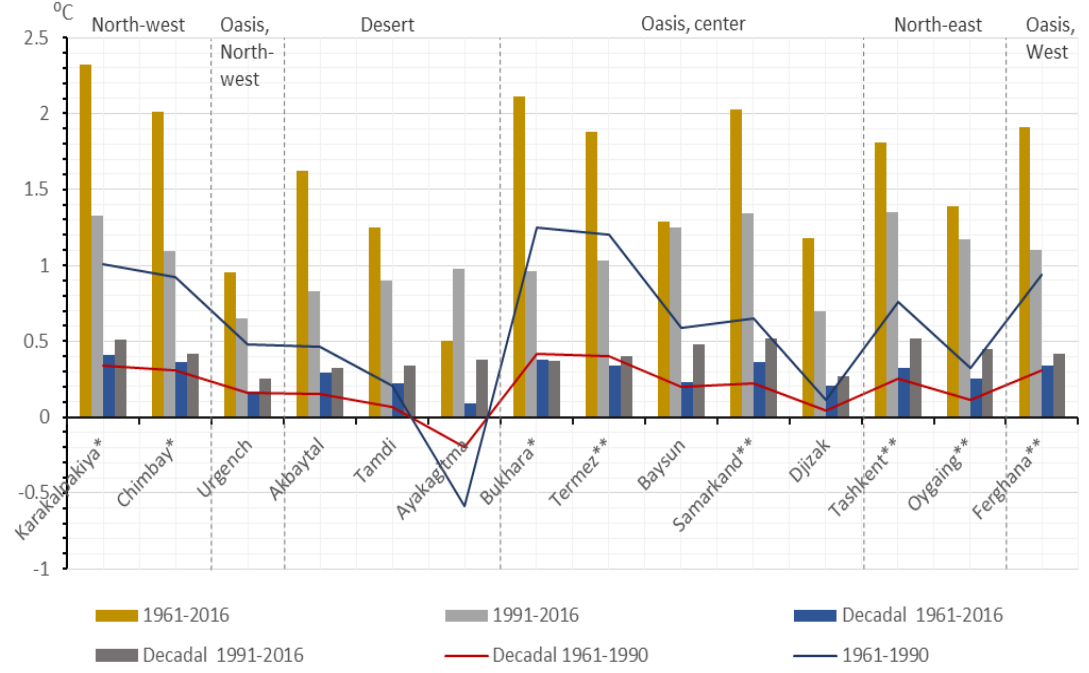
Figure 6. Characteristics of the mean annual temperature change trend at the representative stations in Uzbekistan to the baseline period. * Significance level of 95% for 1991–2016, ** Significance level of 95% for 1961–2016. (see Appendix A: Table A3).